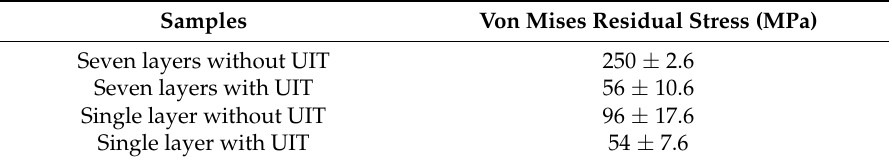
Table 2. The top region residual stress of both the single-layer and the seven-layer as-deposited and post-UIT